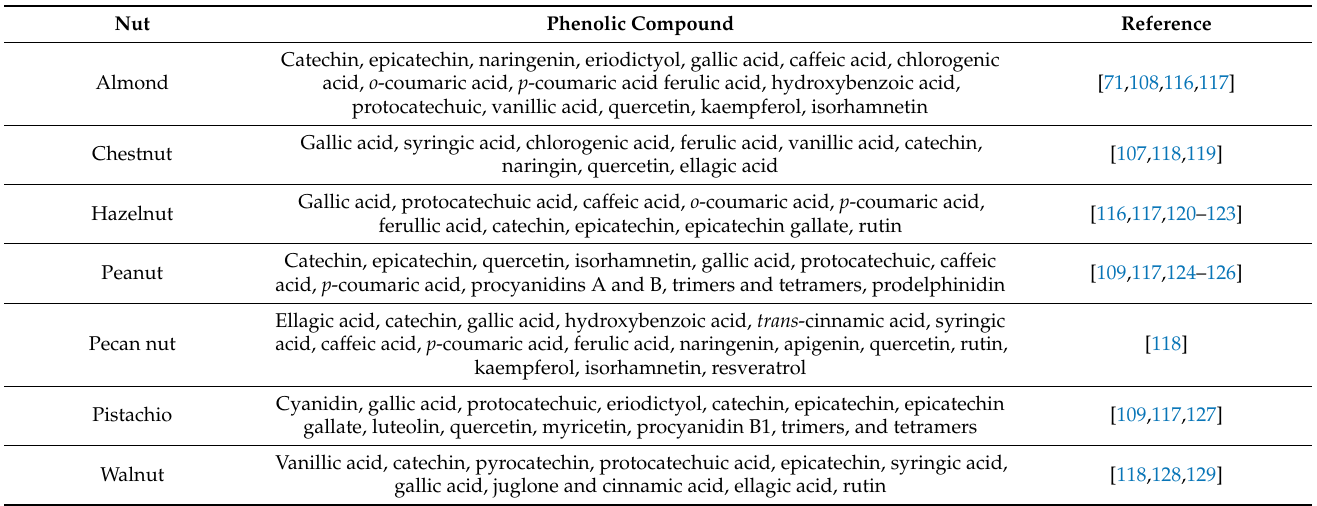
Table 6. Main phenolic compounds found in the most common nuts (skins +